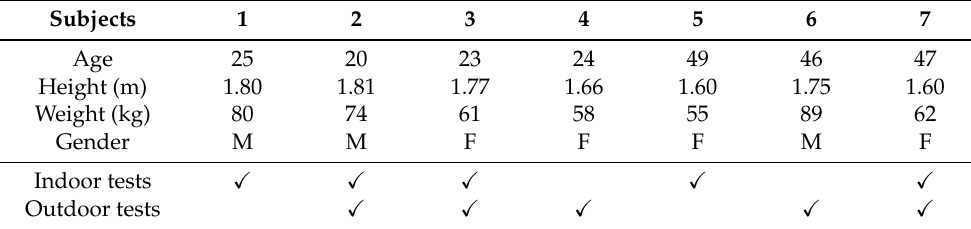
Table 1. Demographics of the